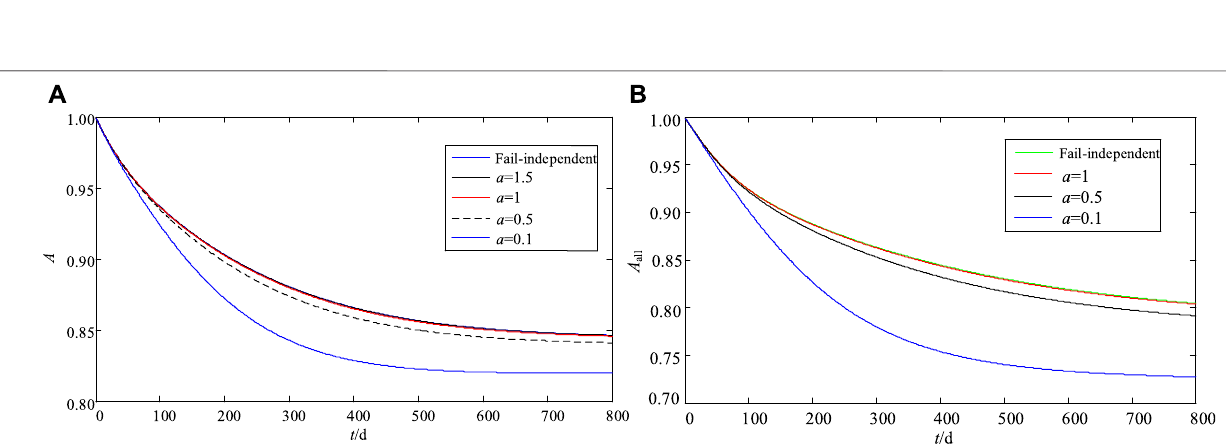
Frontiers in Energy Research |